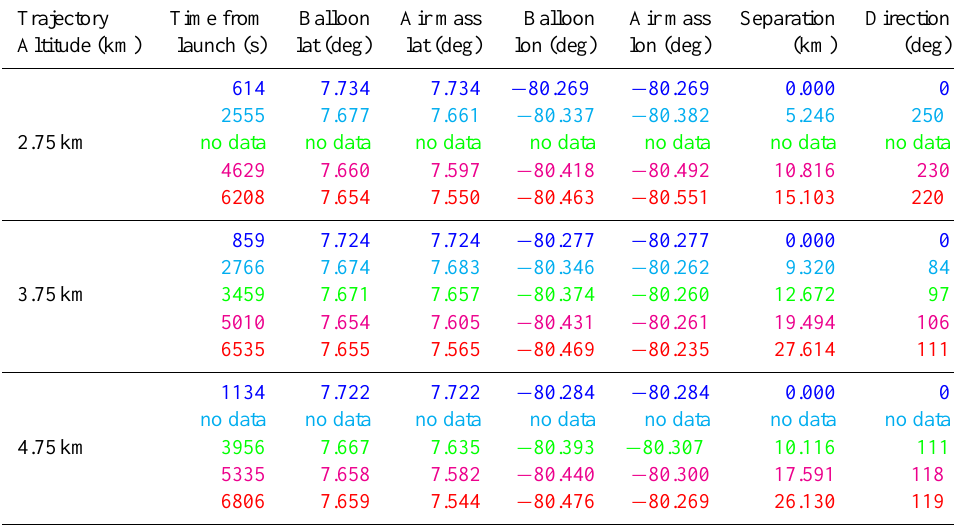
Table 3. Balloon trajectory and estimated air mass trajectories at three different altitudes within the 2.5–5.1km layer in which the balloon oscillated. “No data” are reported when the balloon did not oscillate through the level of the air mass trajectory calculation. The “Direction” column indicates the compass heading from the balloon location to the estimated air mass location. Color-coding matches that for the balloon data shown in Figs. 4, 5, 8, 9, and 11. See text for